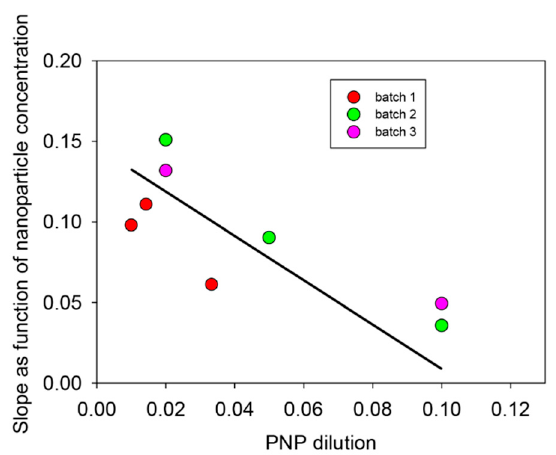
Figure 8. Evolution of the slope of the curves shown in Figure 7B as a function of the PNP dilution (mother solution at (4.6 ± 0.4) × 10 − 4 mol · L − 1 ) for three independent batches of PDA@ALP nanoparticles. The solid line does not correspond to a fit, but is aimed to guide the eye.